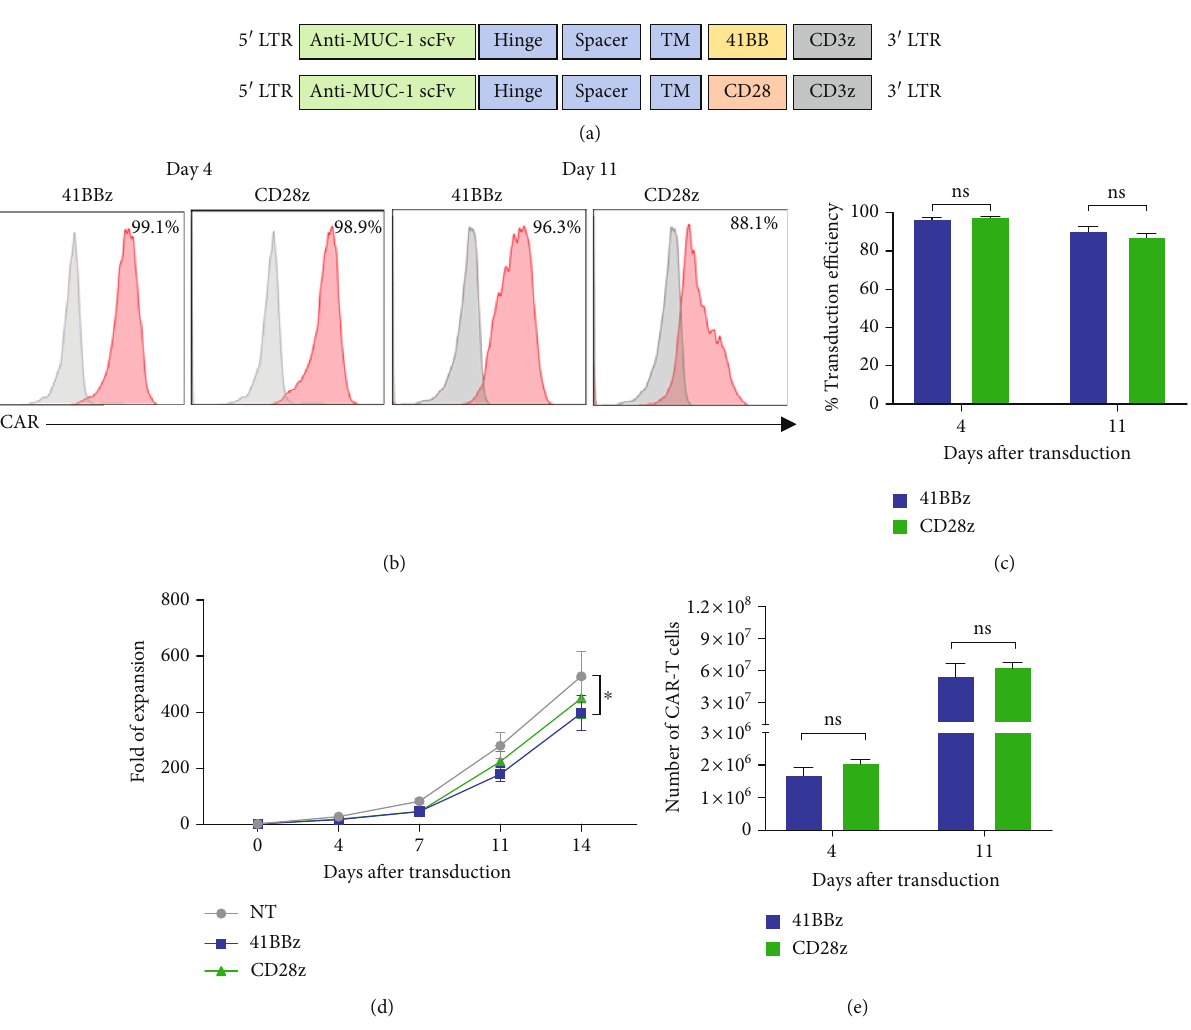
Figure 1: Generation of CAR T cell targeting tumor associated MUC1. (a) Schematic of CAR MUC1 constructs with either CD28 ζ or 4-1BB ζ costimulatory signaling domain. (b) Representative histogram demonstrating CAR.MUC1-41BB ζ and CAR.MUC1-CD28 ζ expression on day 4 and day 11 after transduction. (c) Transduction e ffi ciency of CAR.MUC1-41BB ζ and CAR.MUC1-CD28 ζ . Data are shown as mean ± S : E : M from 6 independent donors. (d) Ex vivo expansion of CAR.MUC1-41BB ζ and CAR.MUC1-CD28 ζ . Cell numbers were determined by